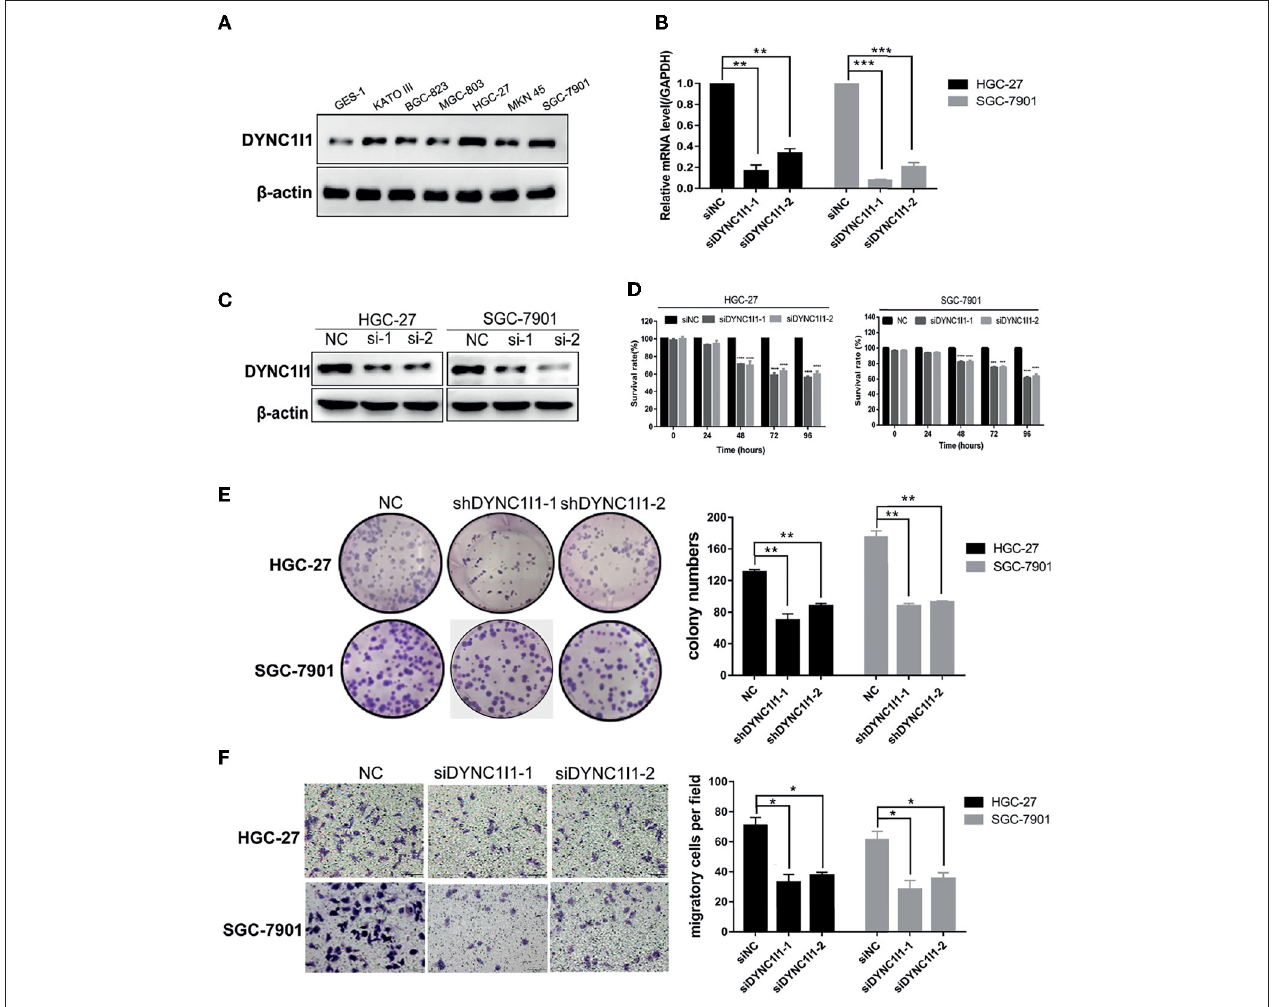
FIGURE 2 | Knockdown of DYNC1I1 leads to suppression of gastric cancer progression and migration in vitro . (A) Western blot shows DYNC1I1 protein expression levels in normal gastric cells and different gastric cancer cells. (B) and (C) RT-qPCR and western blot show DYNC1I1 transcription level and protein expression after transient knockdown DYNC1I1 gene by using siRNAs for 48h. (D) MTT shows cell viability of gastric cancer cells after knocking down DYNC1I1 for 0, 24, 48, 72, 96h. (E) Colony formation shows gastric cancer cells form colony ability after knocking down DYNC1I1. (F) Transwell assay displays the change in migration of gastric cancer cells after knocking down DYNC1I1 or not (magnification × 200). (* P < 0.05, ** P < 0.01,*** P < 0.001,**** P < 0.0001, n = 3, student t -test, means ± 95%